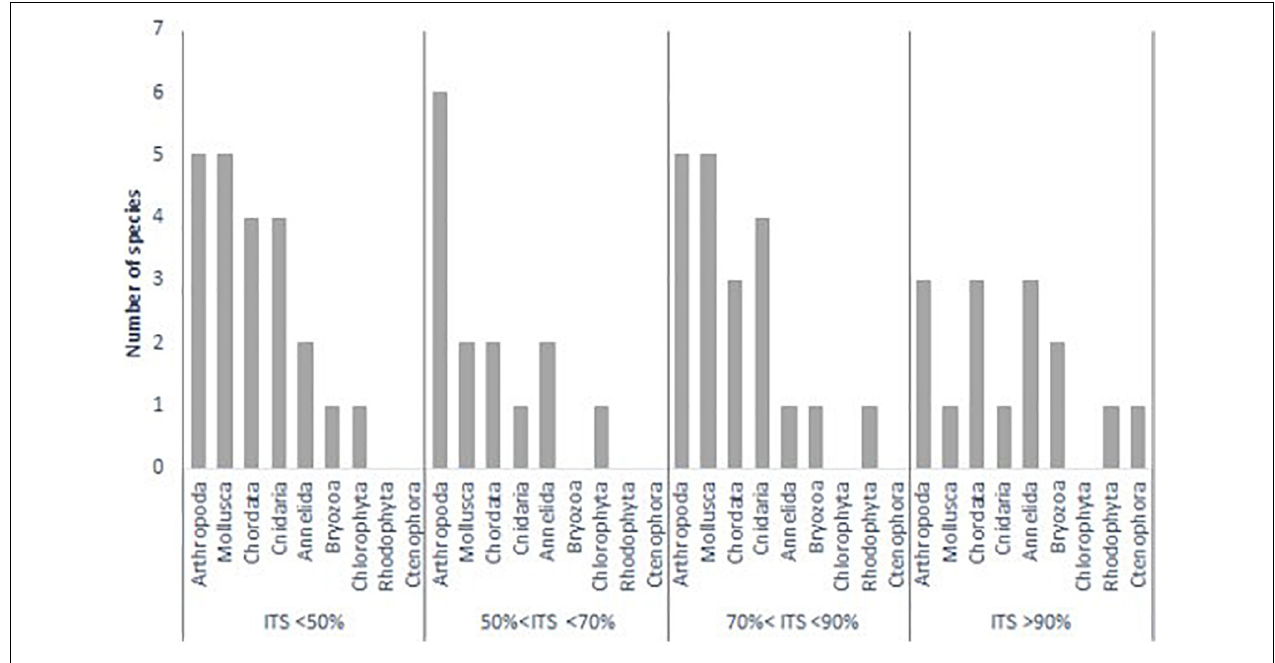
FIGURE 2 | Count of species belonging to different phyla grouped based on their invasion threat scores (NIS-ITS) TABLE 1 | Non-indigenous species (NIS) with more than a 90% invasion threat score (NIS-ITS) in the port of Gijon. Species NIS-ITS